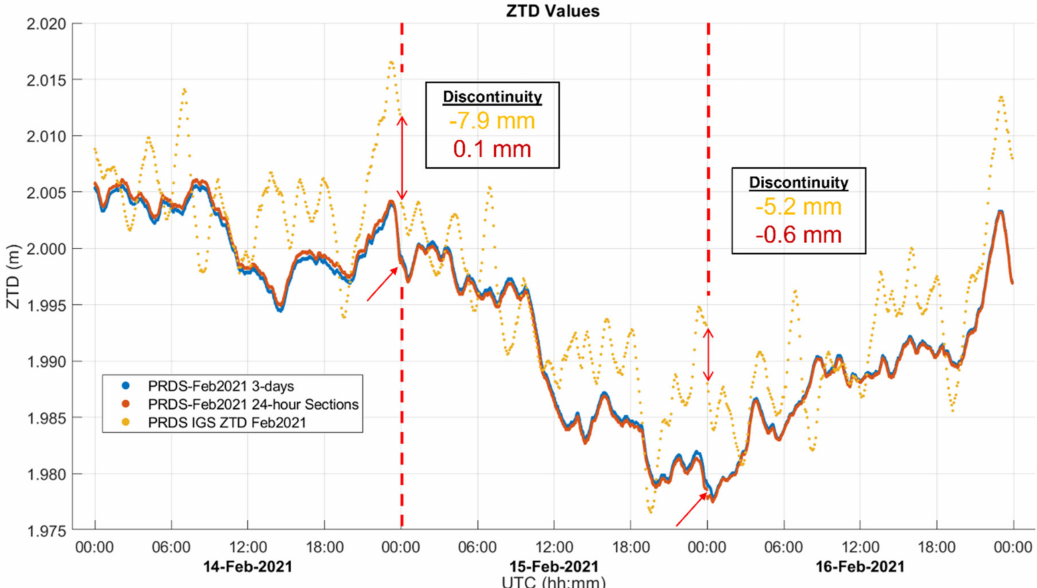
Figure 4. ZTD comparison between IGS-derived values (yellow) and CSRS-PPP (v3.50.0) continuous (blue) and 24 h (red) profiles over three days at IGS PRDS